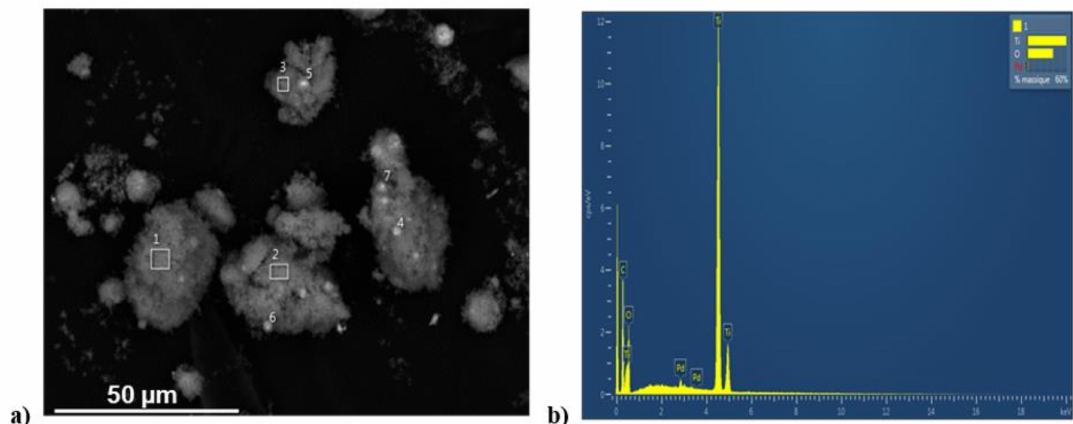
Figure 4. Elemental mapping by EDAX for the TiO 2 -Pd/IWI sample: ( a ) overall aspect, ( b ) average elemental composition on the selected